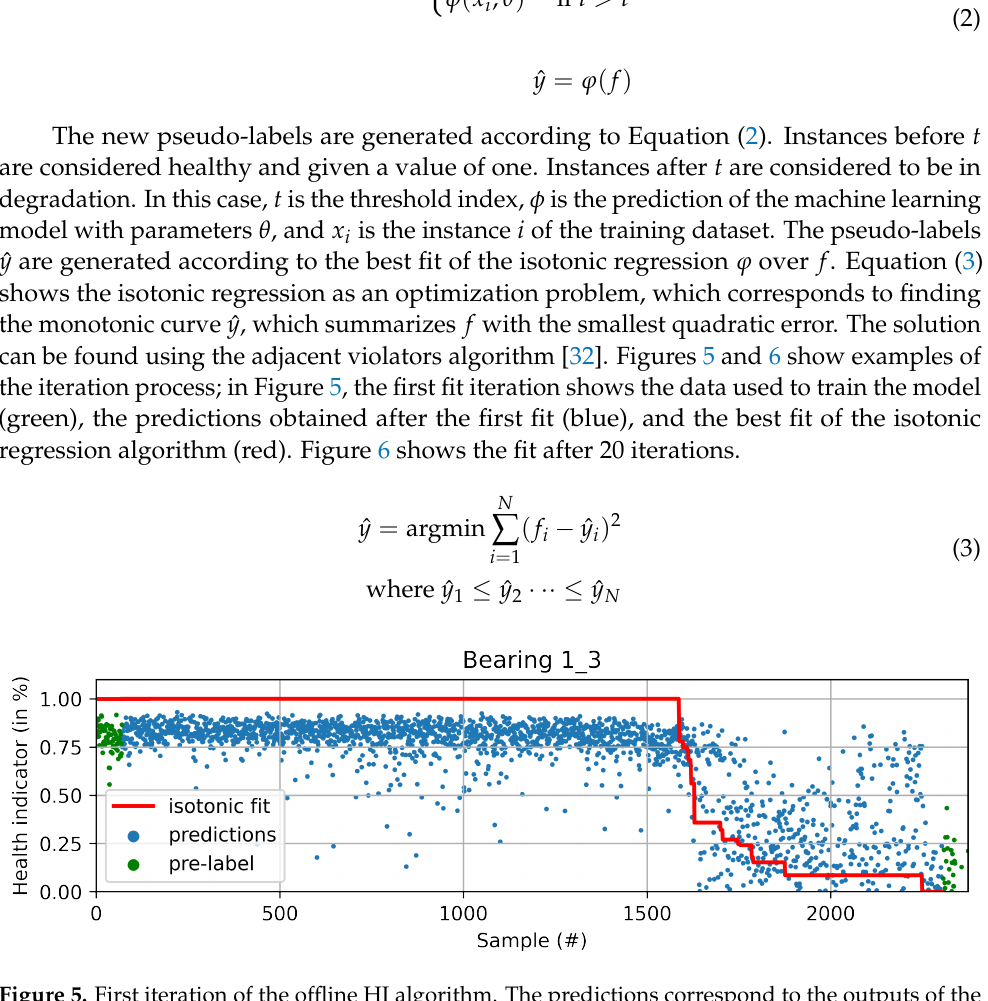
Figure 5. First iteration of the offline HI algorithm. The predictions correspond to the outputs of the model after training for one iteration with only labels for the first and last samples (labeled in green).